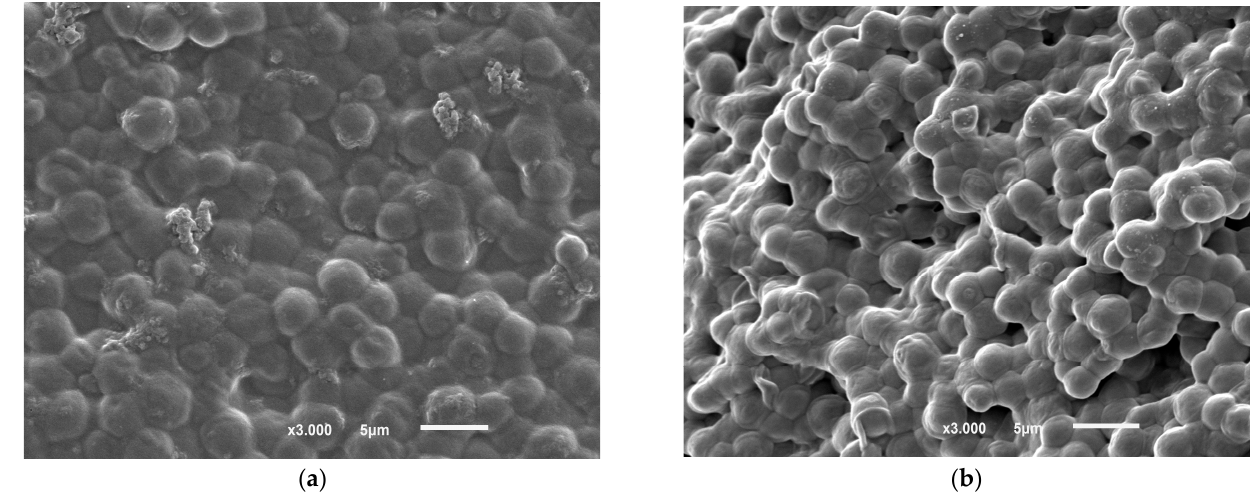
Figure 12. SEM analysis of Rhodotorula sp. surface ( a ) before and ( b ) after Cr 6+ biosorption.